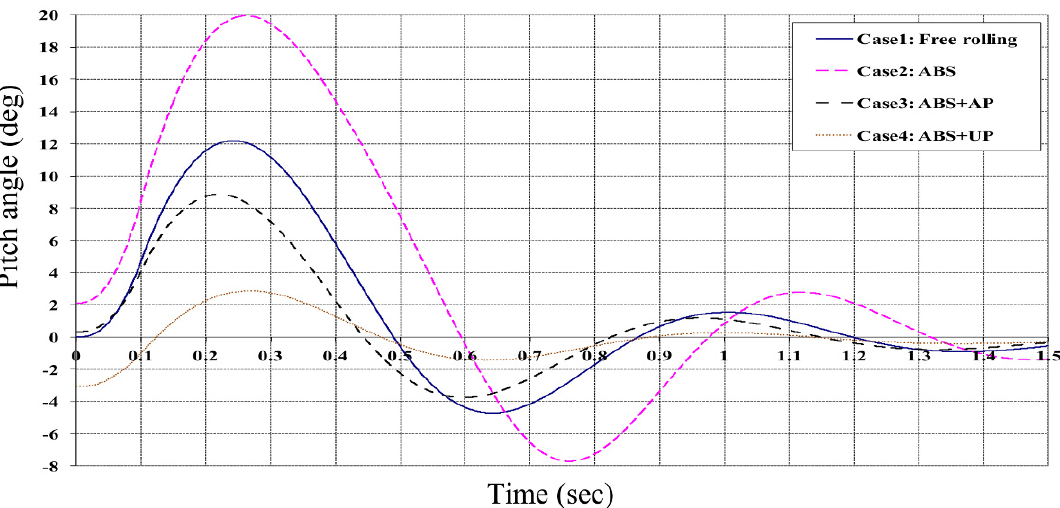
Figure 19. Pitch angle of the vehicle body for all cases at offset collision and speed of 70